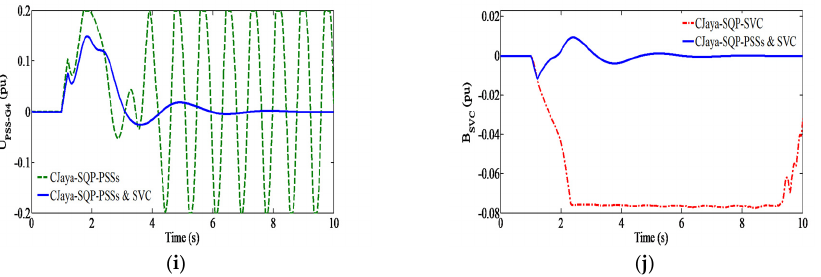
Figure 20. Power systemdynamic responses for scenario IV: ( a ) Speed deviation response of G1-G2; ( b ) Speed deviation response of G3-G4; ( c ) Speed deviation response of G1-G3; ( d ) Speed deviation response of G1-G4; ( e ) Rotor angle response of G1-G3; ( f ) Rotor angle response of G2-G3; ( g ) PSS output signal response at generator G1; ( h ) PSS output signal response at generator G2; ( i ) PSS output signal response at generator G4; and ( j ) SVC susceptance response.